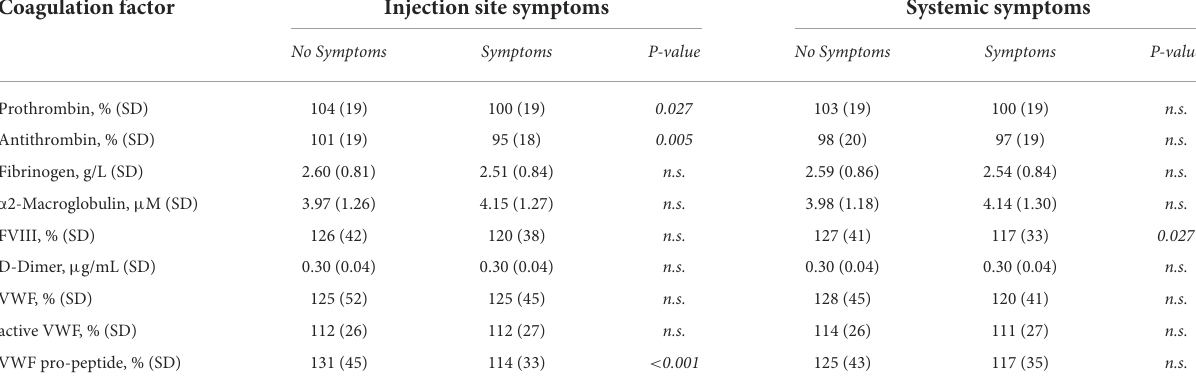
TABLE 2 The association of coagulation factor levels and clinical symptoms after the second round of vaccination as reported by subjects vaccinated with ChAdOx1-S with and without prior COVID-19 infection. Coagulation factor Injection site symptoms Systemic symptoms No Symptoms Symptoms P-value No Symptoms Symptoms P-value